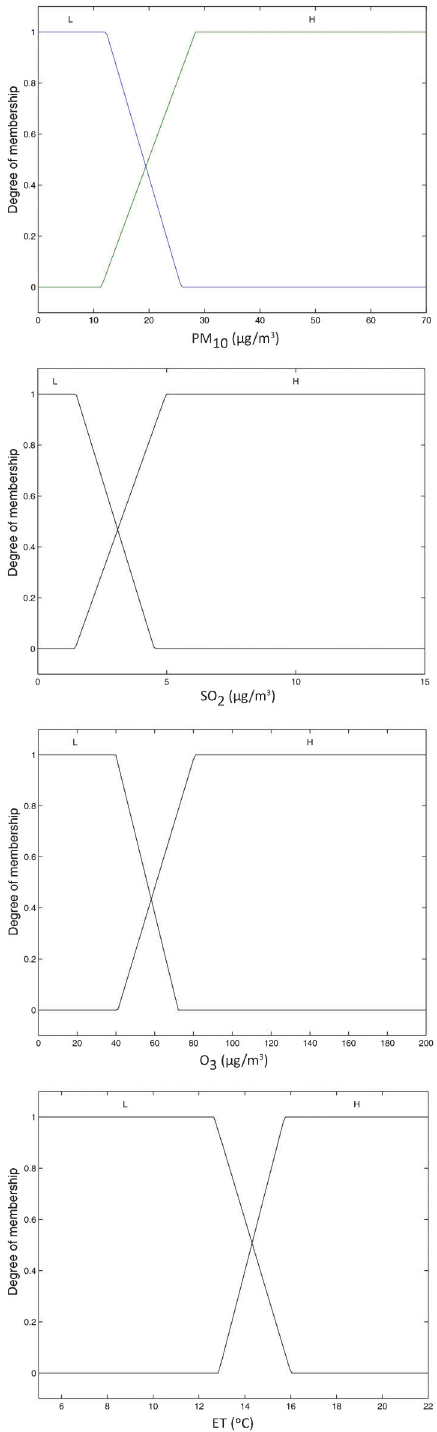
Figure 1. Membership function to particulate matter (PM 10 ), sulfur dioxide (SO 2 ), ozone (O 3 ), and effective temperature